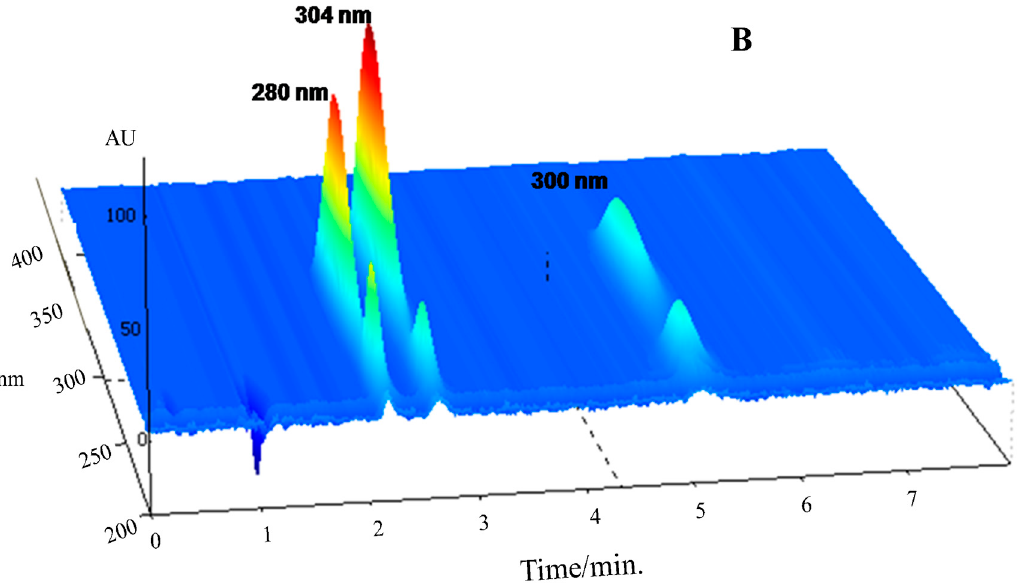
Figure 2. Chromatogram (2D—( A ) and 3D—( B )) of the separation of the guanylhydrazones by HPLC/DAD.